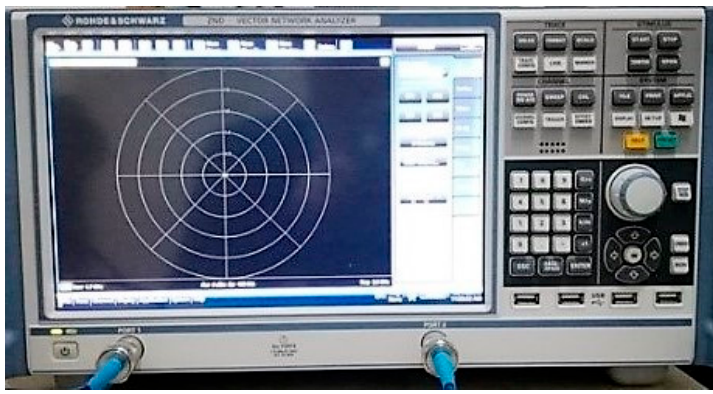
Figure 2. R&S ZND model vector network analyzer.